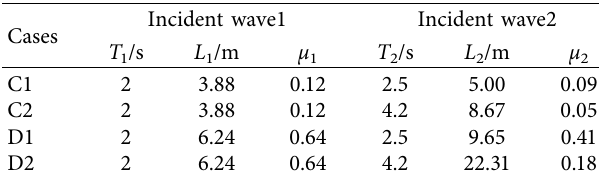
Table 1: Table of the parameters of different combinations of incident waves.